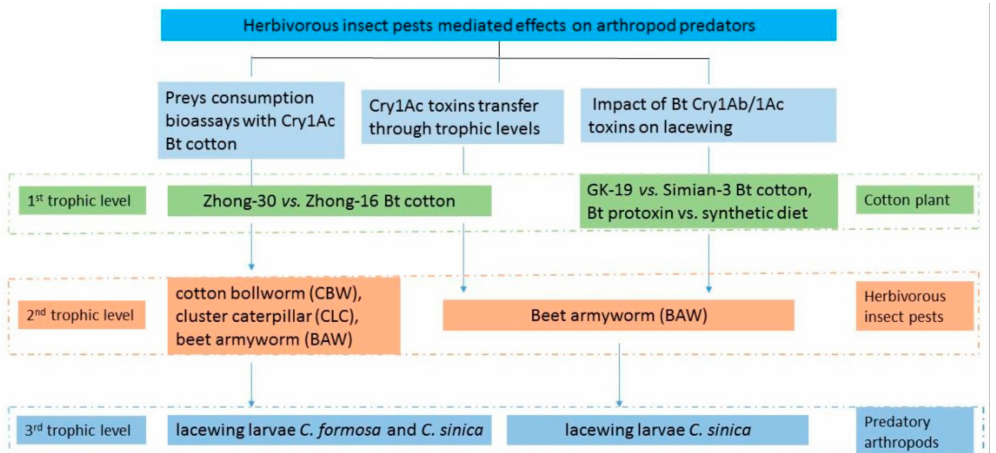
Figure 4. Experimental designs. Bt cotton ‘Zhong-30’ expressing Cry1Ac toxin and its non-transgenic counterpart ‘Zhong-16’ were used to study preys consumption bioassays and to measure toxin transfer through trophic levels, while ‘GK-19’ expressing Cry1Ab/1Ac fusion toxin and its non-transgenic counterpart ‘Simian-3’ were used to study the impact of toxin on